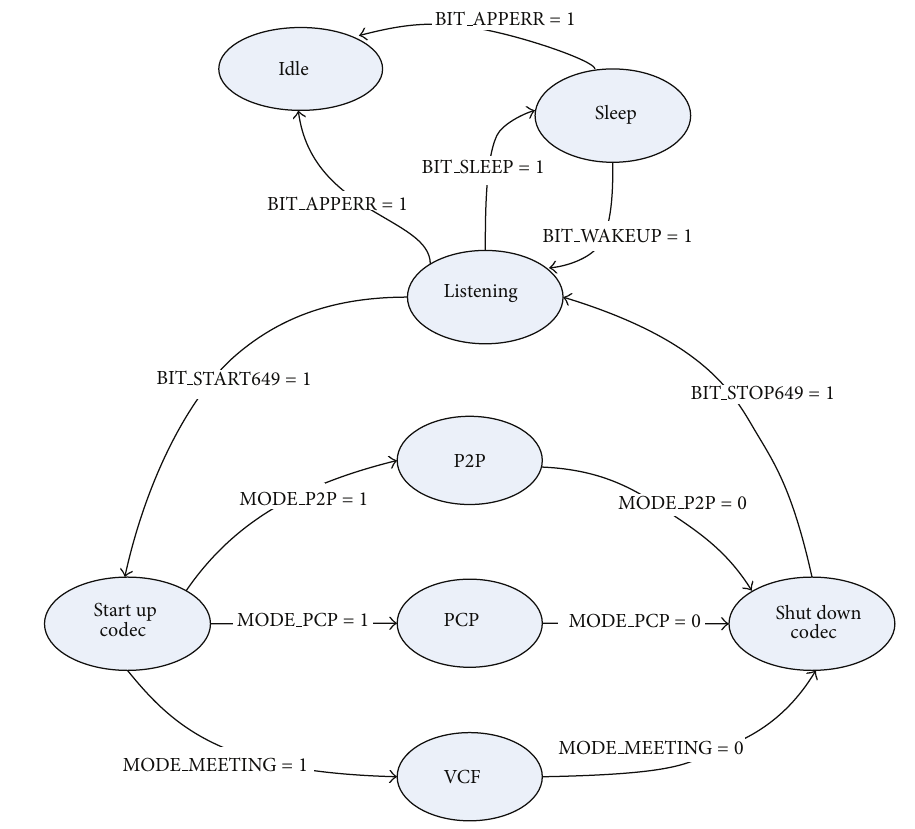
Figure 6: State machine of ANODE.